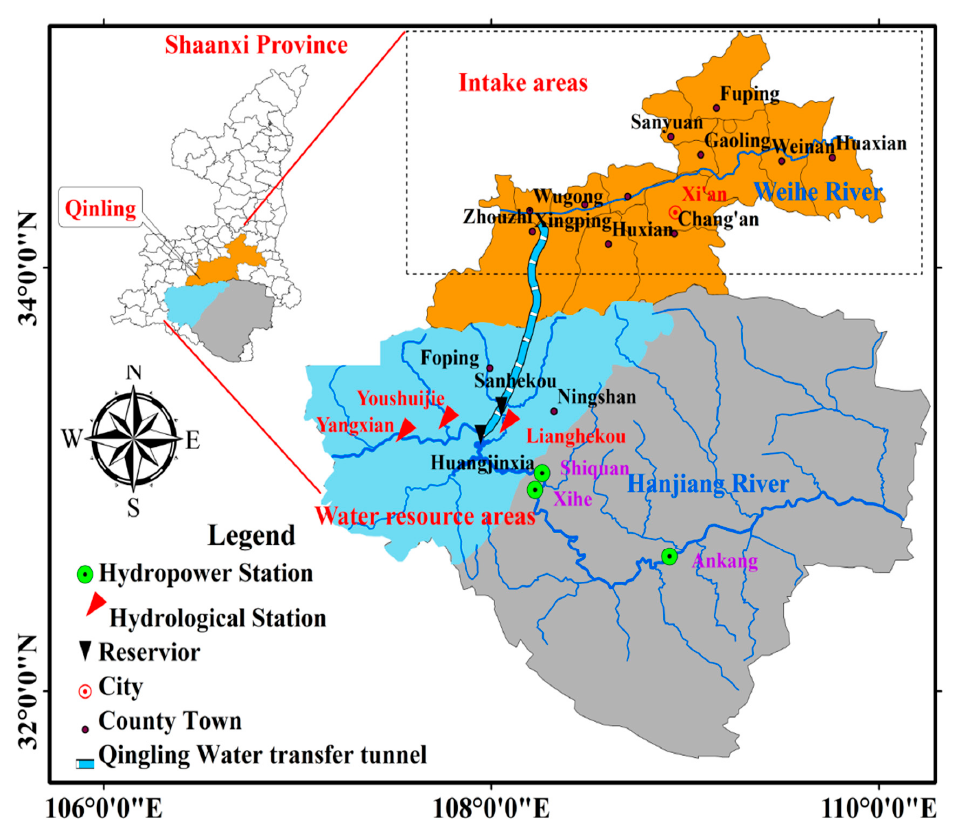
Figure 1. distribution map of power stations and reservoirs in the upper Han River, the blue area is water resource areas of the Project, the brown area is intake areas of the Project and the gray area is power stations in the downstream of the Project.